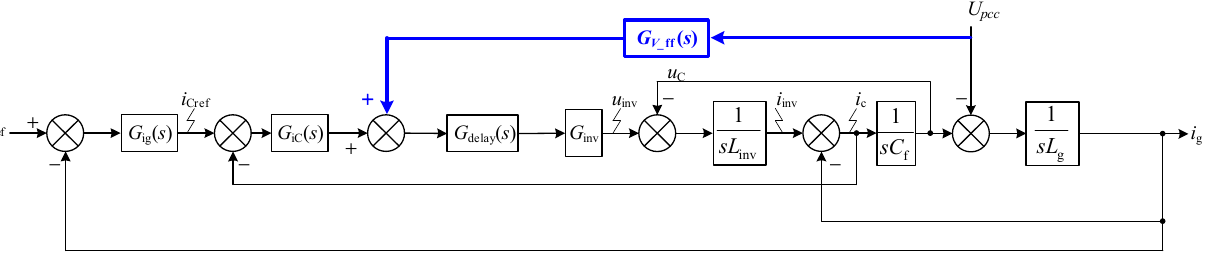
Figure 14. Structure diagram of grid-tie converter considering power grid voltage full feedforward control.